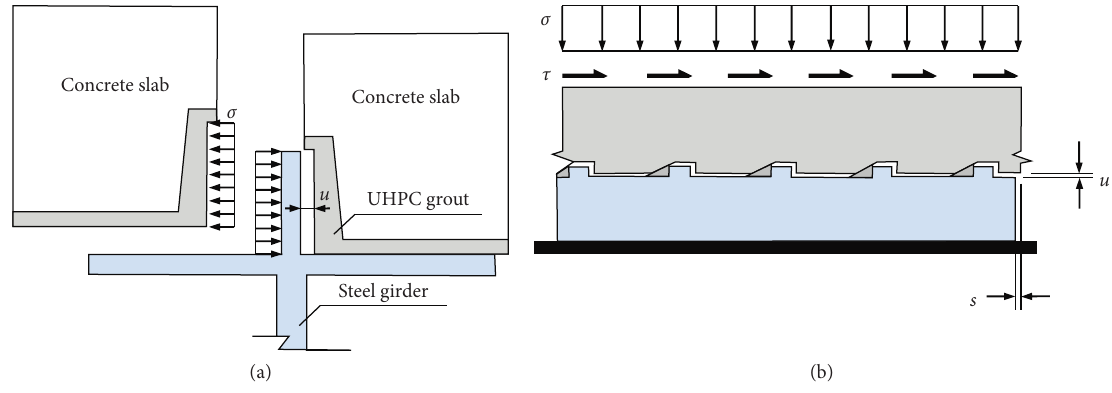
Figure 13: Development of confinement due to uplift.